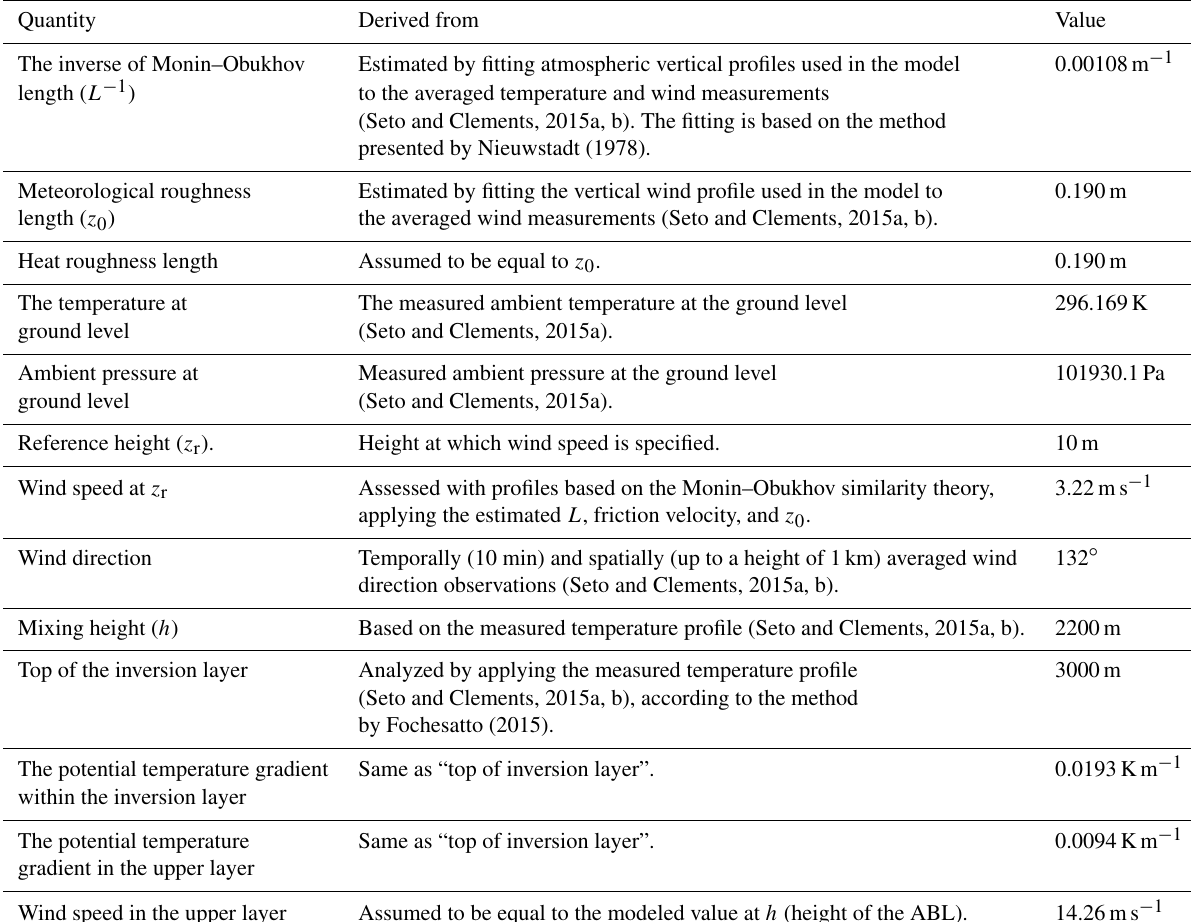
Table 1. Summary of the meteorological information required by the BUOYANT model related to the L2F burn of the RxCADRE experi- mental campaign. References to applied experimental data (where applicable) are presented in the column “Derived